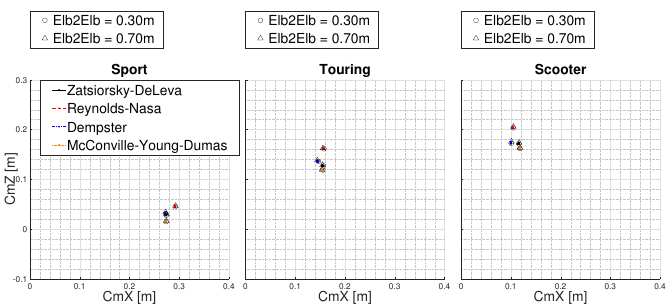
Figure 6. Position of the center of mass as a function of elbow distance.